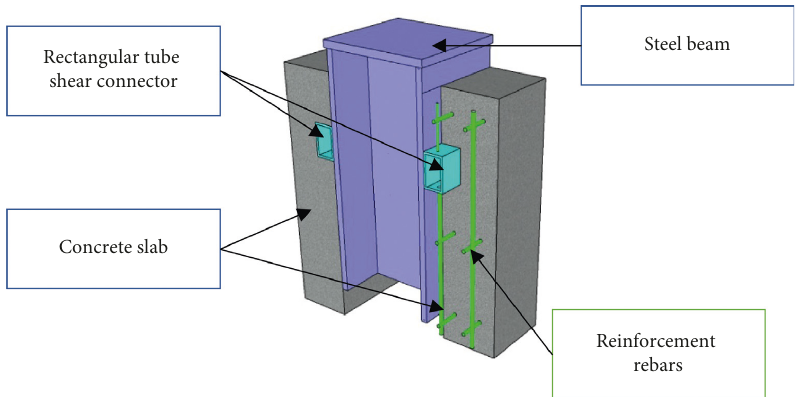
Figure 22: Steel-concrete composite slab with RSP.